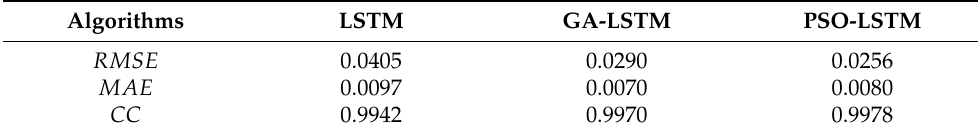
Table 2. Performance criteria of the noise prediction.